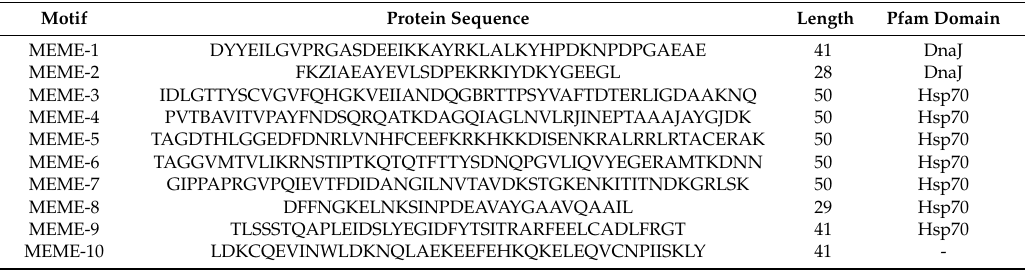
Figure 3. Phylogenetic relationships, exon motif patterns, and conserved protein motif of buffalo HSP gene family. ( A ) Phylogenetic tree of 64 buffalo HSP proteins. ( B ) Exon pattern of buffalo HSP. ( C ) Motif pattern of buffalo HSP proteins gene family. Ten putative motifs are indicated in different colored boxes. For details of motifs, refer to Table 5. ( D ) Conserved protein motif. Table 5. Ten differentially conserved motifs of heat-shock protein gene family observed in buffalo.